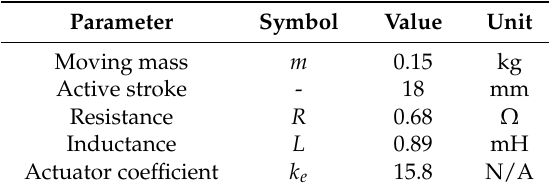
Table 1. Main parameters of the linear electromagnetic actuators